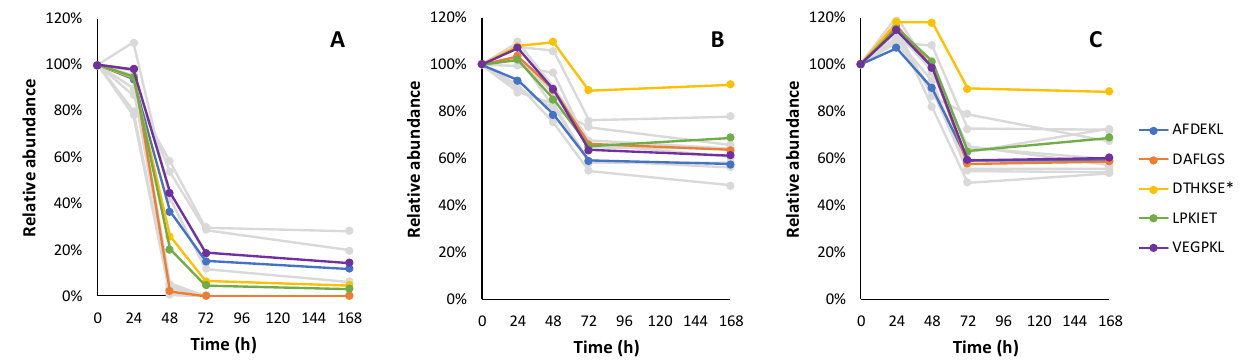
Figure 6. The relative consumption trends of 19 pentapeptides in fermentation with Lalvin ICV Opale 2.0™ ( A ), Lalvin Persy™ ( B ) and Lalvin QA23™ ( C ) of the modified synthetic must with added BSA hydrolysate as the peptide source. The five pentapeptide candidates with the highest abundance are shown in colour. Other pentapeptide candidate sequences and their observed rela- tive consumption trends are shown in Table A7.